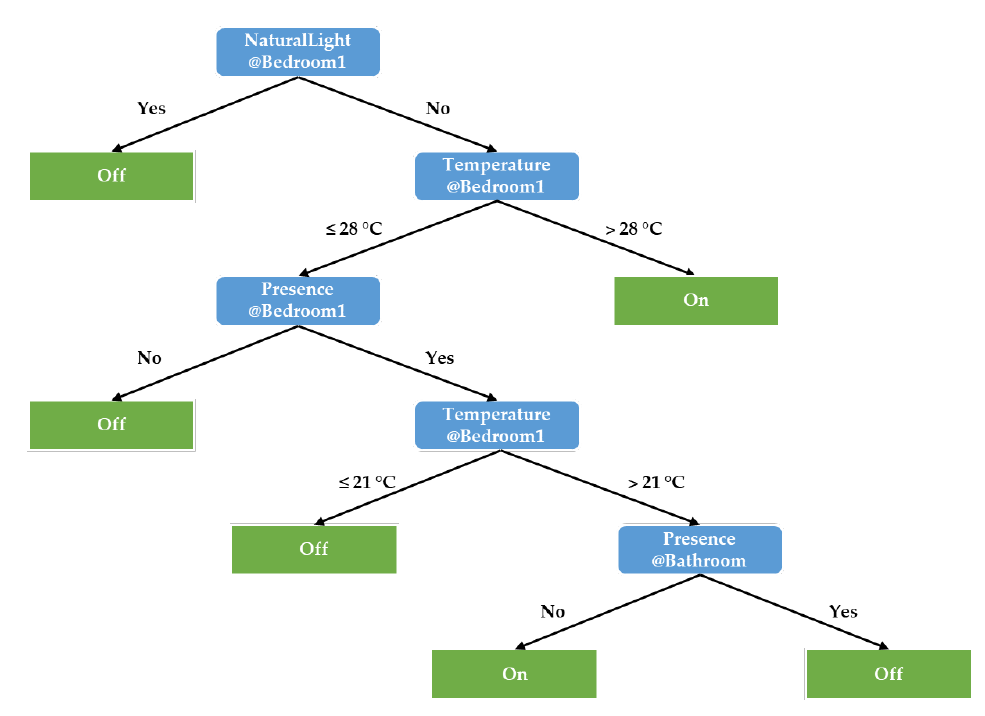
Figure 10. Decision tree for Bedroom 1 AC over Period 2.